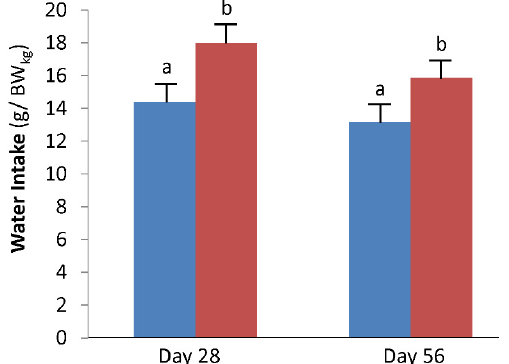
Figure 1. Water intake (g/BW kg per day) after 28 and 56 days of treatment. Cats consumed either control water (deionized; blue; n = 6) or 1% methylcellulose water (viscous; red; n = 6) for 56 days and were then switched to the other water type for 56 days. Shown are least-square means ± pooled standard errors of means for all cats ( n = 12) while consuming the control or viscous water type. a,b Means with different superscripts within a period are different. Water intake was significantly greater in both groups of cats at day 28 compared with day 56.